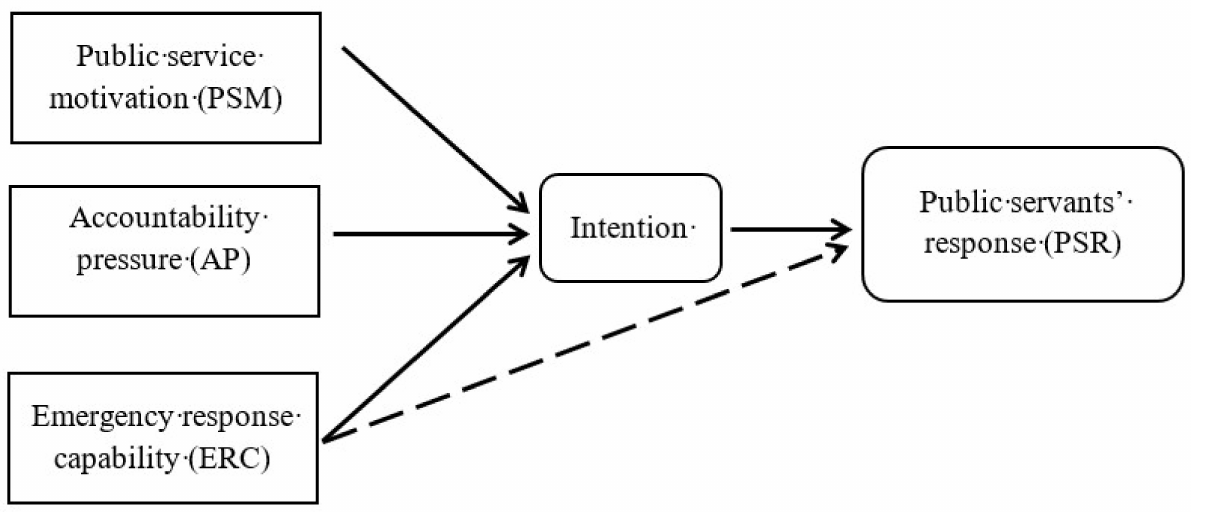
Figure 1. Conceptual